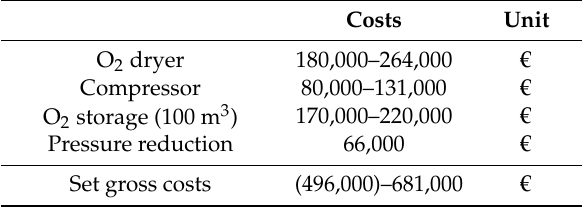
Table 7. Ranges of gross costs of the components for oxygen storage and